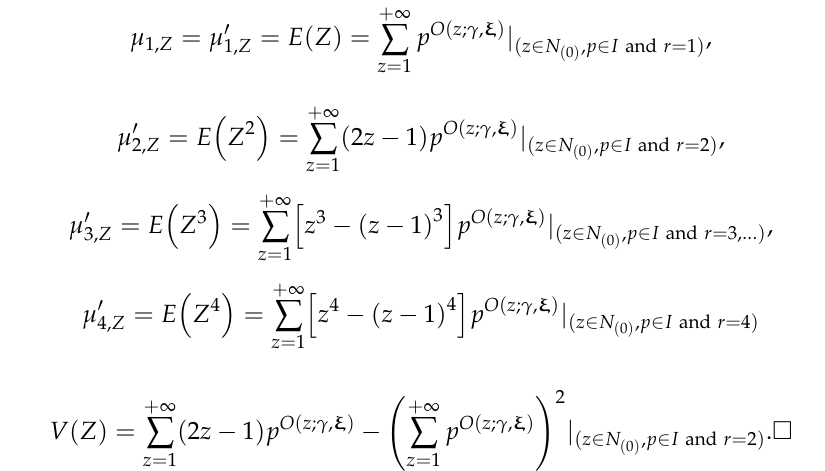
, µ (cid:48) , µ (cid:48) , and µ (cid:48) under the DEGW 2, Z 3, Z 1, Z 4, Z